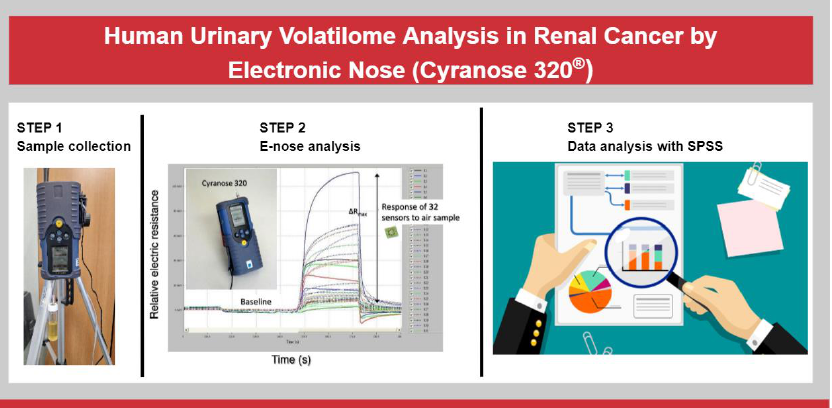
Figure 2. ROC Curve Analysis. In ROC analysis, the discrimination accuracy (AUC—area under the curve) between renal patients and healthy controls was 0.85. Repeated analyses with a second meas- ure obtained from the same urine samples set provided comparable findings (CVA 81.3%, AUC 0.9, sensitivity 71.8% and specificity 88.7%).